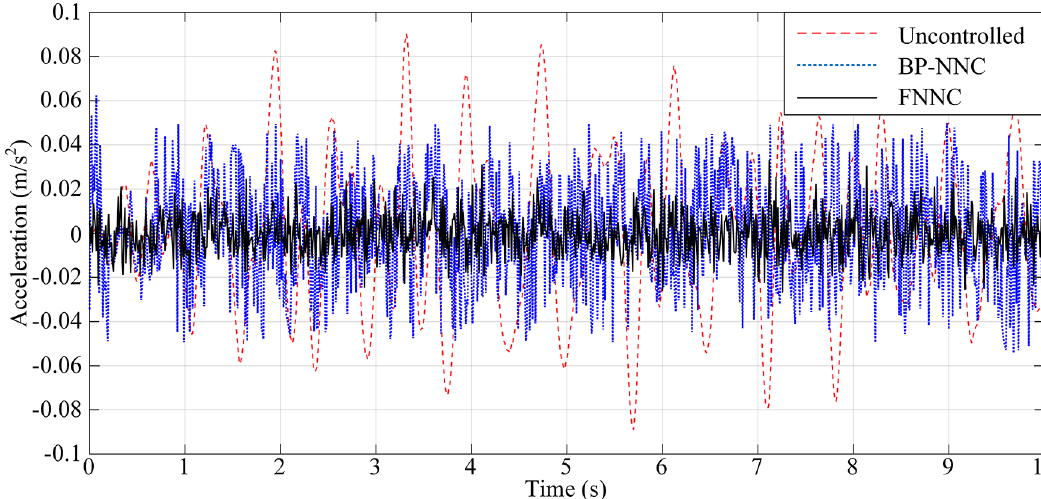
Fig. 21. Time-domain response of horizontal vibration acceleration of the elevator car with a full load.